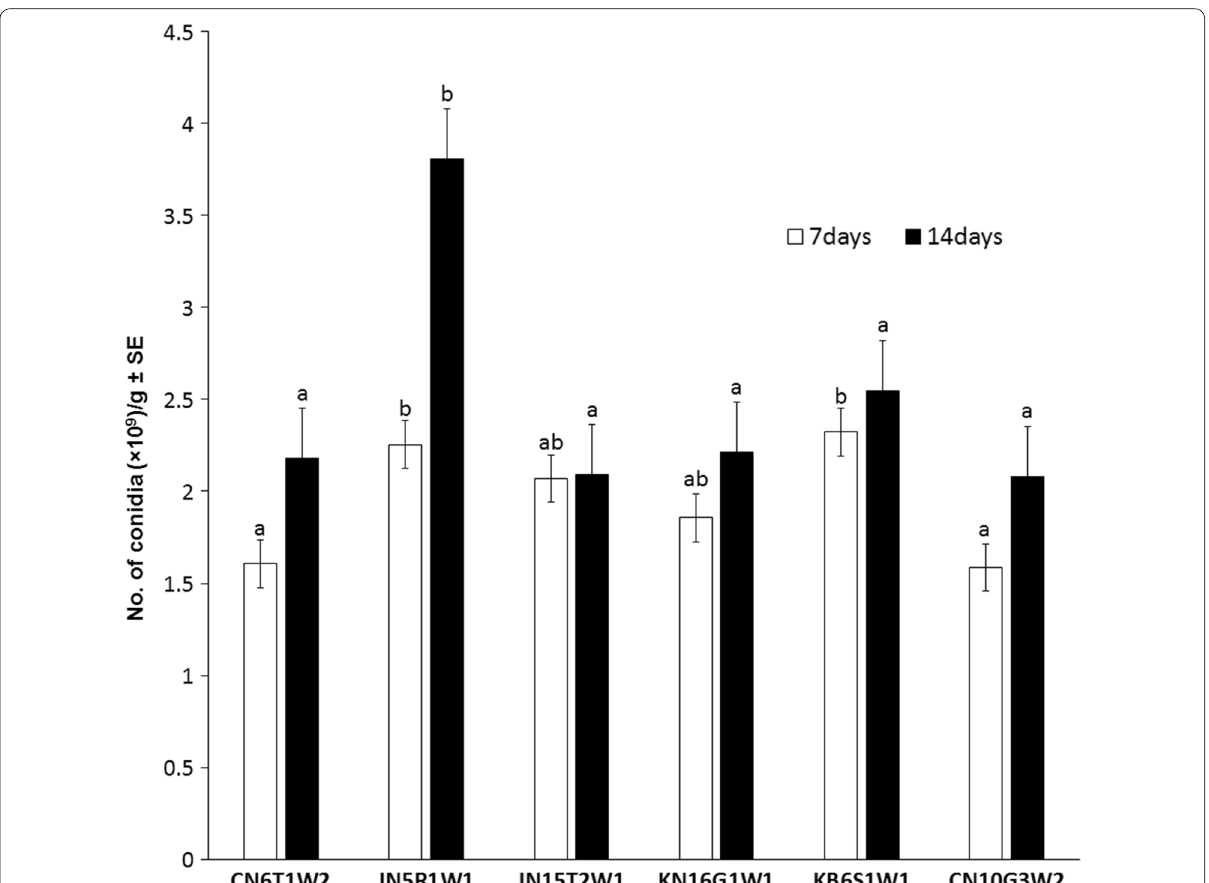
Fig. 1 Productivity of B. bassiana conidia on millet grain medium. Conidia were sampled at 7 days and 14 days after inoculation of each B. bassiana isolate. Data are expressed as the mean standard error (SE). Values with different letters are significantly different ( p < 0.05, SNK test in one-way ± ANOVA). All experiments were replicated three